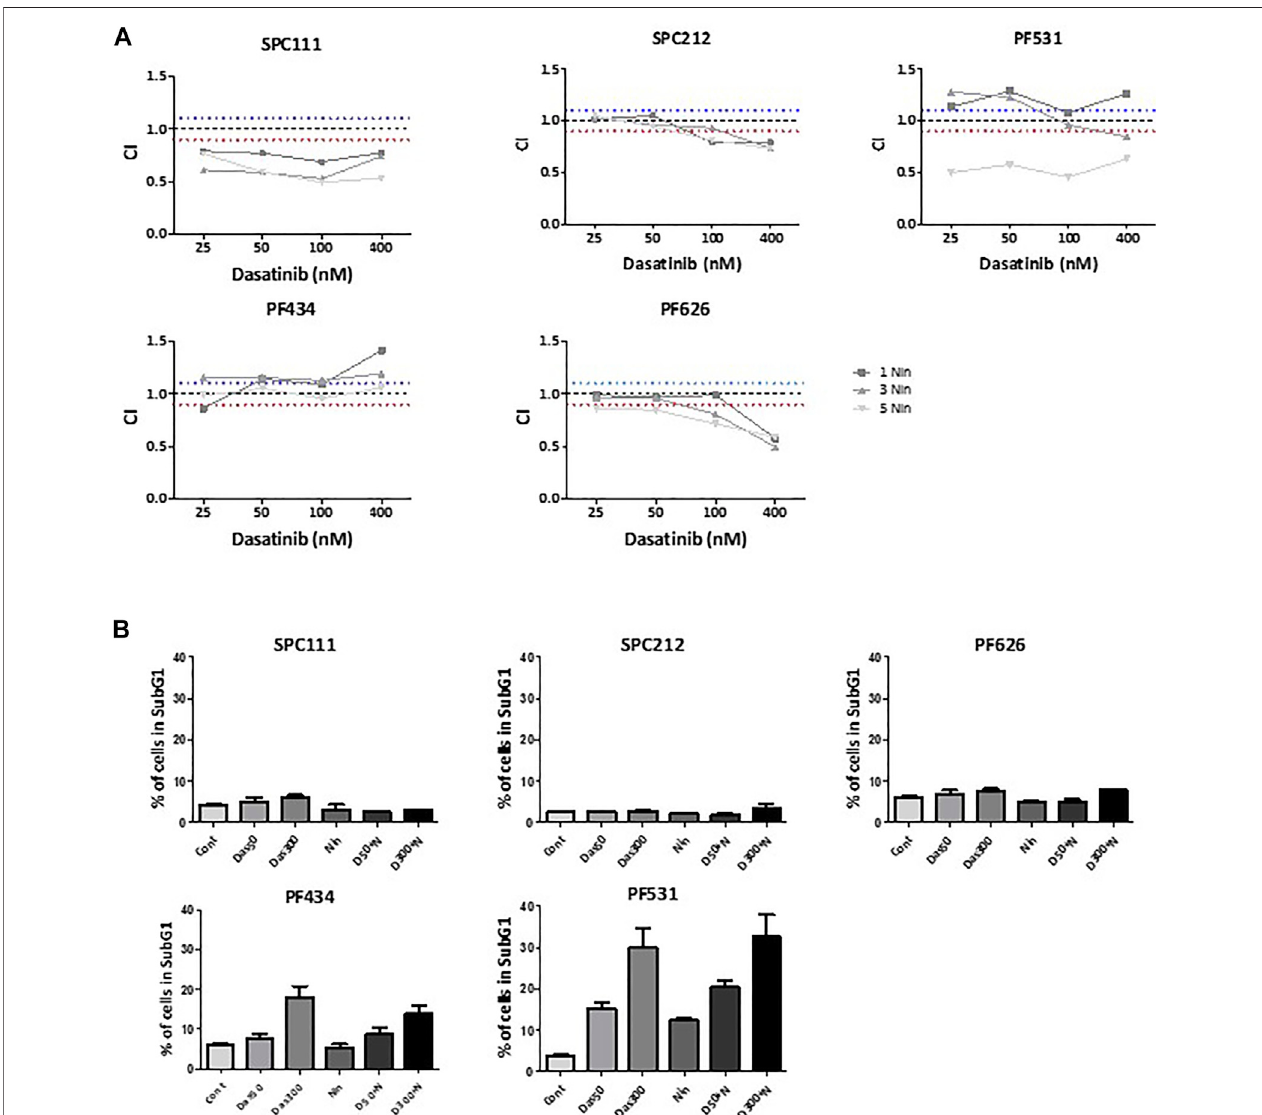
FIGURE 3 | The effect of combination treatment of dasatinib and nintedanib on cell viability and cell cycle (A) Cells were treated with 1 μ M, 3 μ M, 5 μ M nintedanib and 25 nM, 50 nM, 0.1 μ M, 0.4 μ M dasatinib in all combinations for 72 h and cell viability was analyzed with SRB assay. Combination index (CI) was calculated for each combinationandthatindicatedsynergism(CI < 0.9),additiveeffect(CIisbetween0.9and1.1)orantagonism(CI > 1.1).Dottedlinesindicatethesecut-offs (B) Cellcycle analysis was performed after 50 nM or 300 nM dasatinib or 1 μ M nintedanib treatment alone or in combinations for 72 h and the percentage of the cells in the subG1 phase was analyzed. Bars represent means ± SEM from three independent experiments.